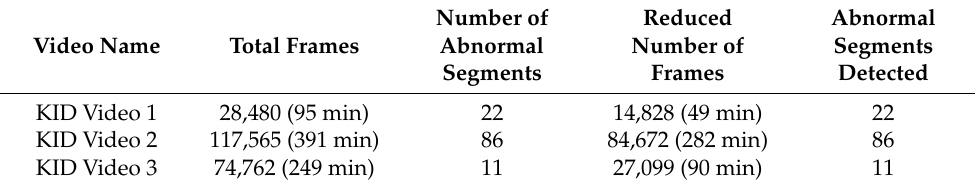
Table 4. Ensemble of Networks Trained on Augmented Videos.